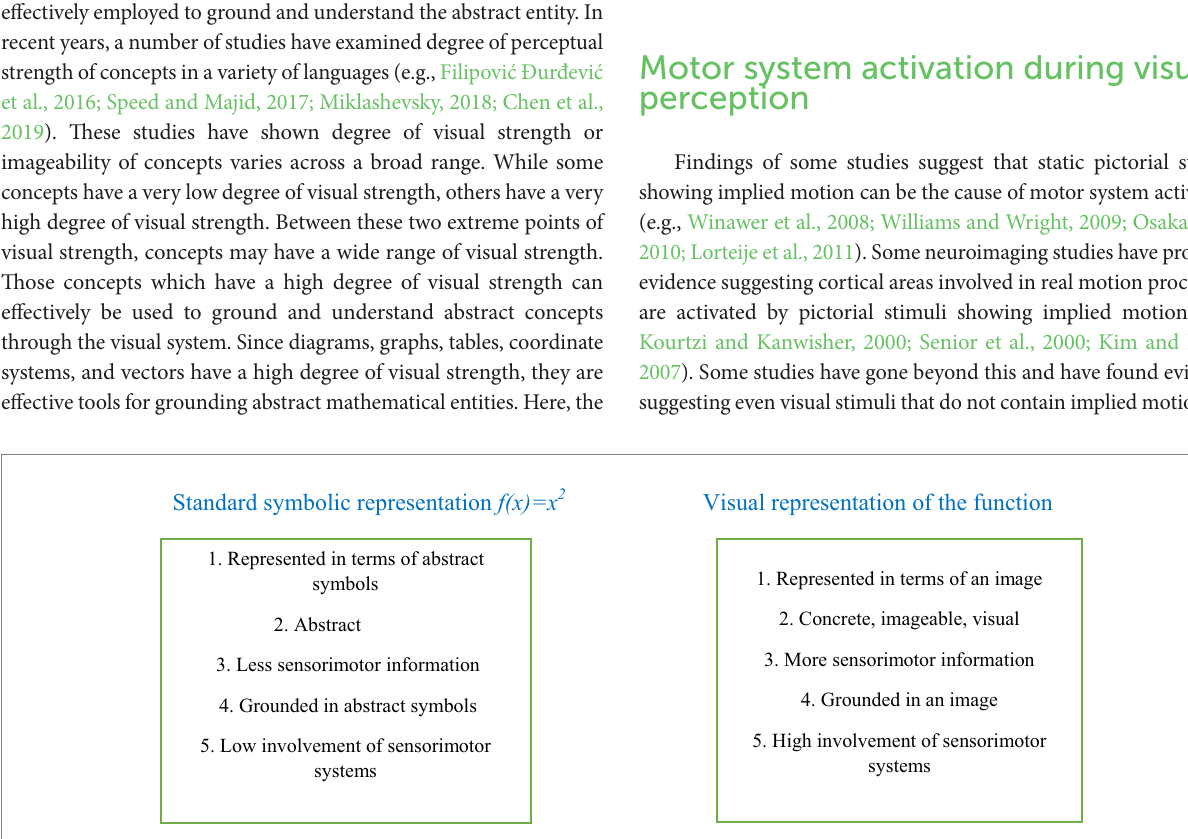
FIGURE 2 A one-to-one comparison between the features of standard symbolic representation of a function and its visual representation standard symbolic representation f(x) = x 2 visual representation of the